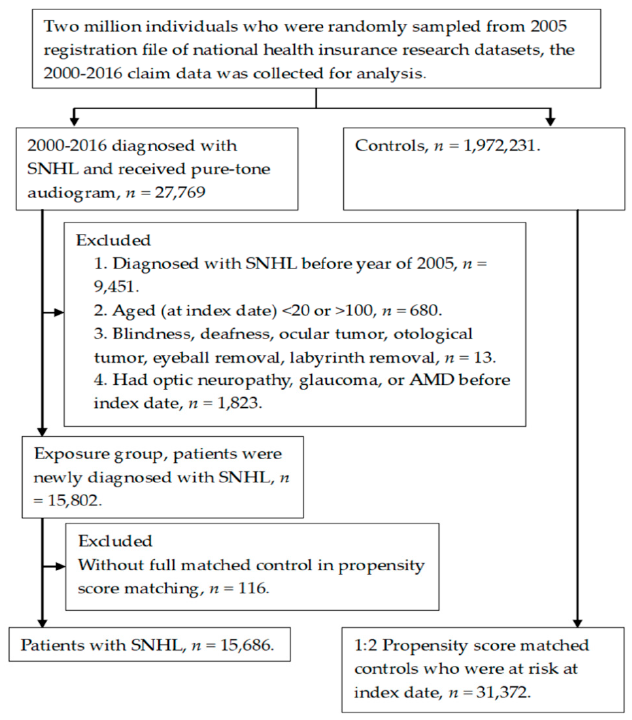
Figure 1. Flowchart of patient enrollment with and without dermatologic vasculature disease.